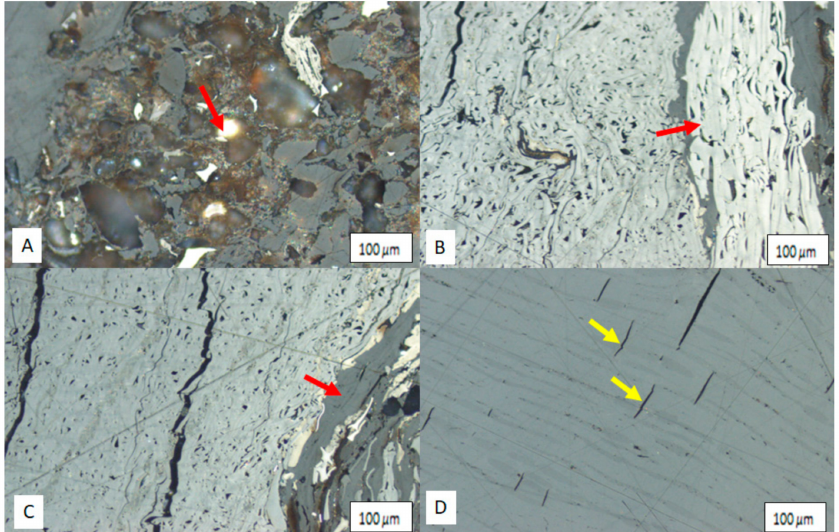
Figure 6. Photomicrographs of coal showing: ( A ) vitrinite with clay and carbonates (red arrow); ( B ) fusinite and semi- fusinite (red arrow) with small layers of vitrinite; ( C ) semi-fusinite with dark grey vitrinite (red arrow) and cracks called pseudovitriite; and ( D ) pseudovitriite (yellow arrows) in light grey